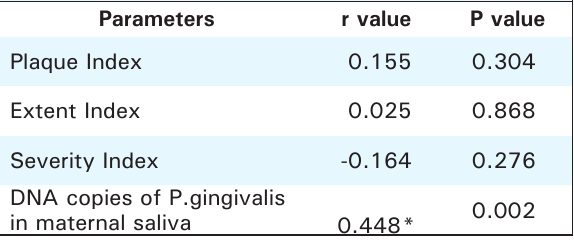
between DNA copies of P.gingivalis in maternal saliva and child’s saliva (Table 4). Table 4. Correlation of DNA copies of P.ginigvalis in child’s saliva with clinical parameters and DNA copies of P.gingivalis in Maternal saliva.